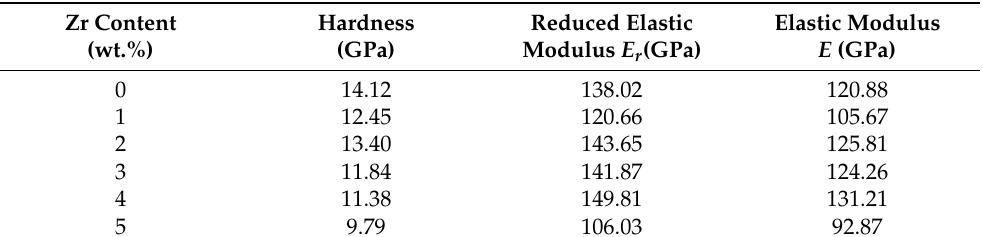
Figure 8. Load–displacement curves for nanoindentation of Nb-Zr Alloy with various Zr content by simulation under 1470 K. Table 2. Material properties obtained from nanoindentation simulation of Nb-Zr with varying Zr content at 1470 K.